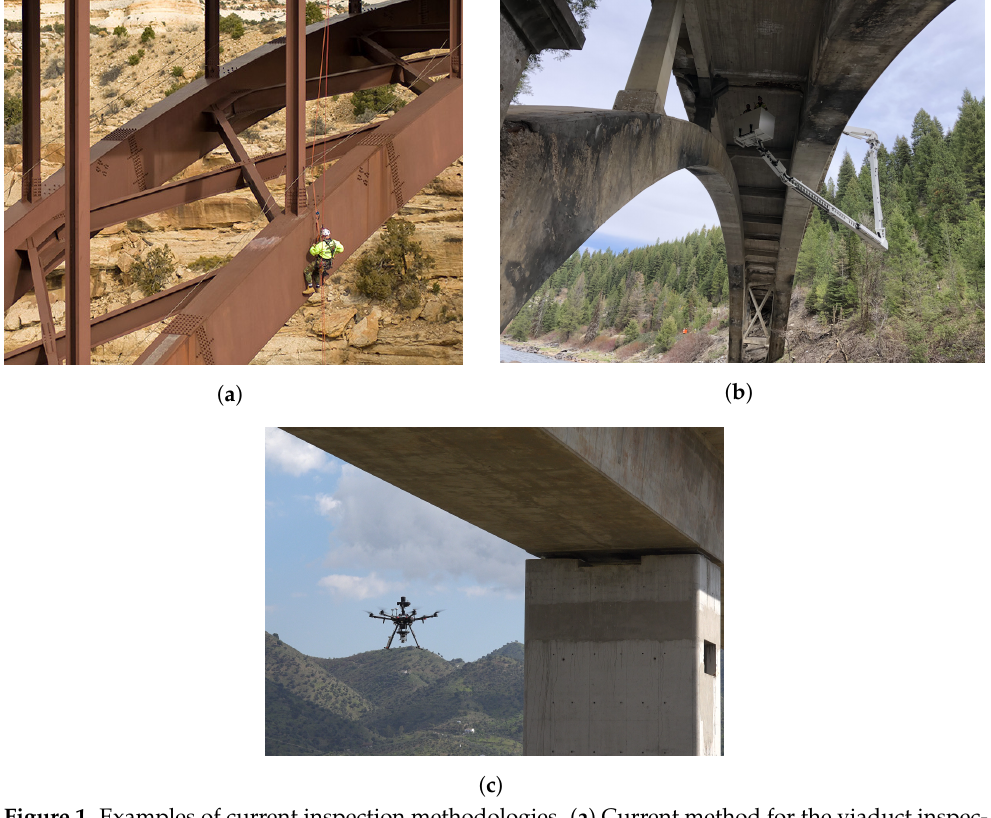
Figure 1. Examples of current inspection methodologies. ( a ) Current method for the viaduct inspec- tion with rope access, from Ayres Associates, Inc. [1]. ( b ) Current method for the viaduct inspection using specialized machinery, from Forsgren Associates, Inc. [2]. ( c ) Proposed new methodology using the flight platform AERO-CAM in Álora, Málaga (Spain) performing an inspection under a viaduct